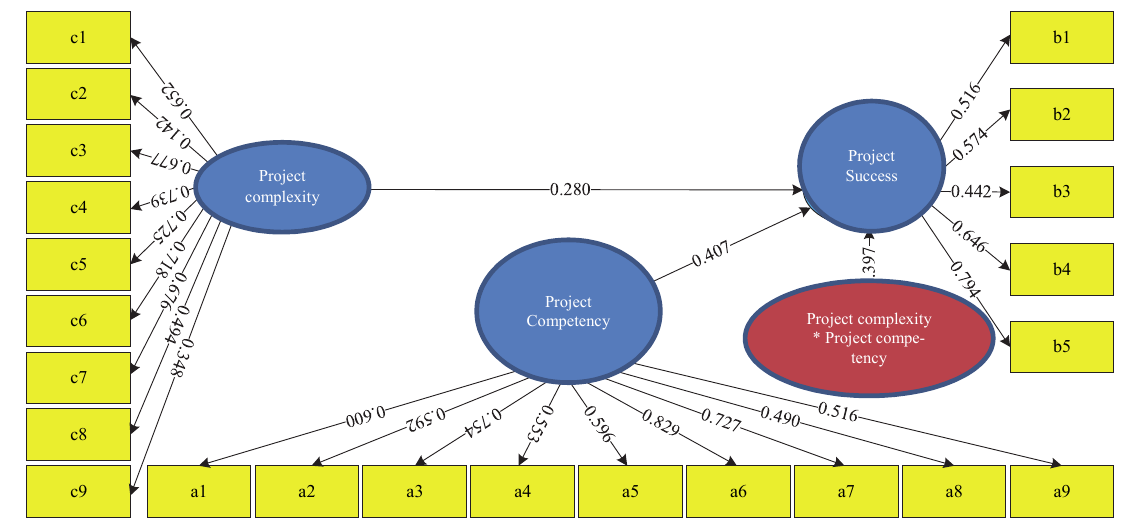
Fig. 3. The relationship between inherent complexity and project success with the role of moderating knowledge competence along with standardized